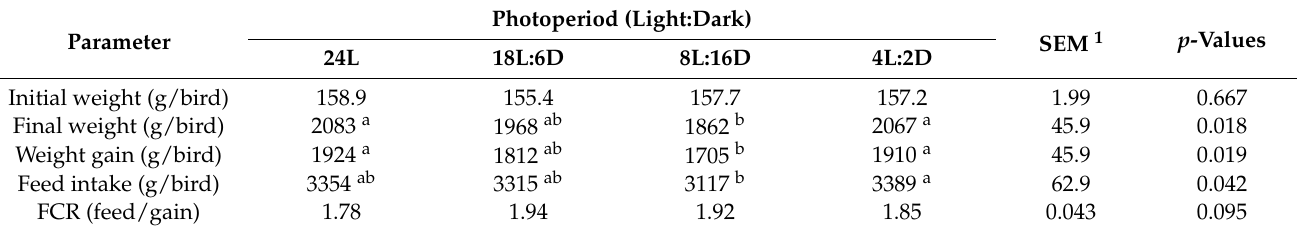
Table 2. Effect of photoperiod on growth performance of broilers.